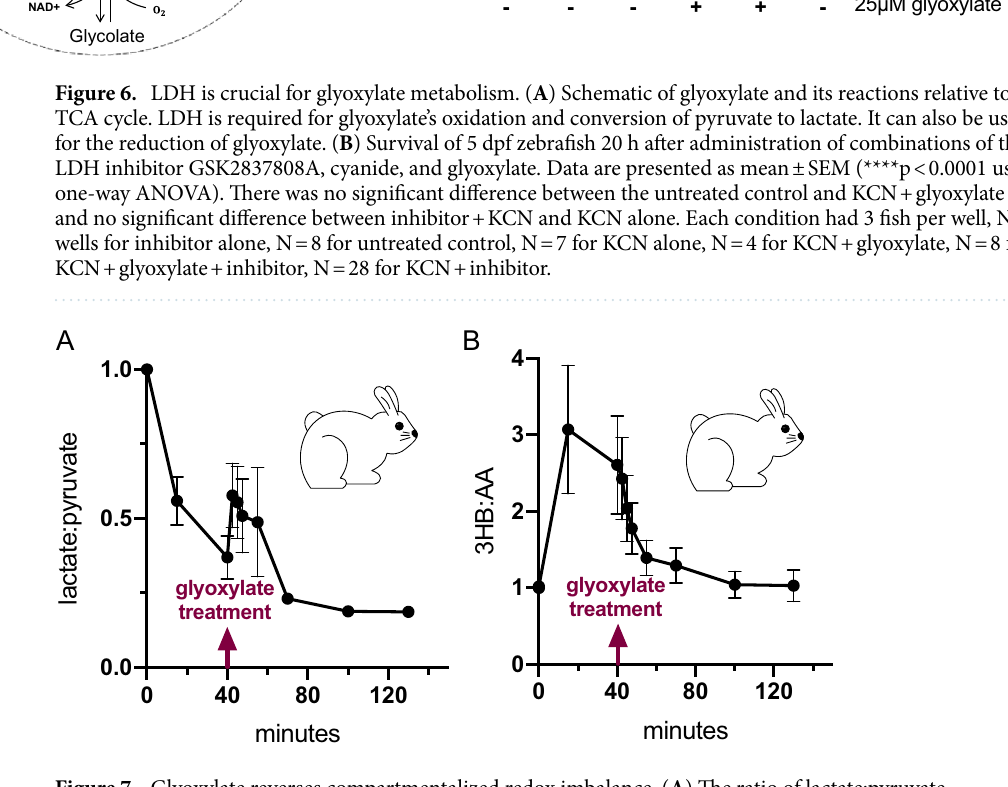
Figure 7. Glyoxylate reverses compartmentalized redox imbalance. ( A ) The ratio of lactate:pyruvate, a surrogate for the ratio of cytosolic NADH to NAD+ and ( B ) the ratio of 3-hydroxybutyrate (3HB) to acetoacetate (AA), a surrogate for the ratio of mitochondrial NADH to NAD+, in serial plasma samples collected from rabbits exposed to a 40 min cyanide infusion followed by i.m. glyoxylate treatment. Data are presented as mean ± SEM, N =